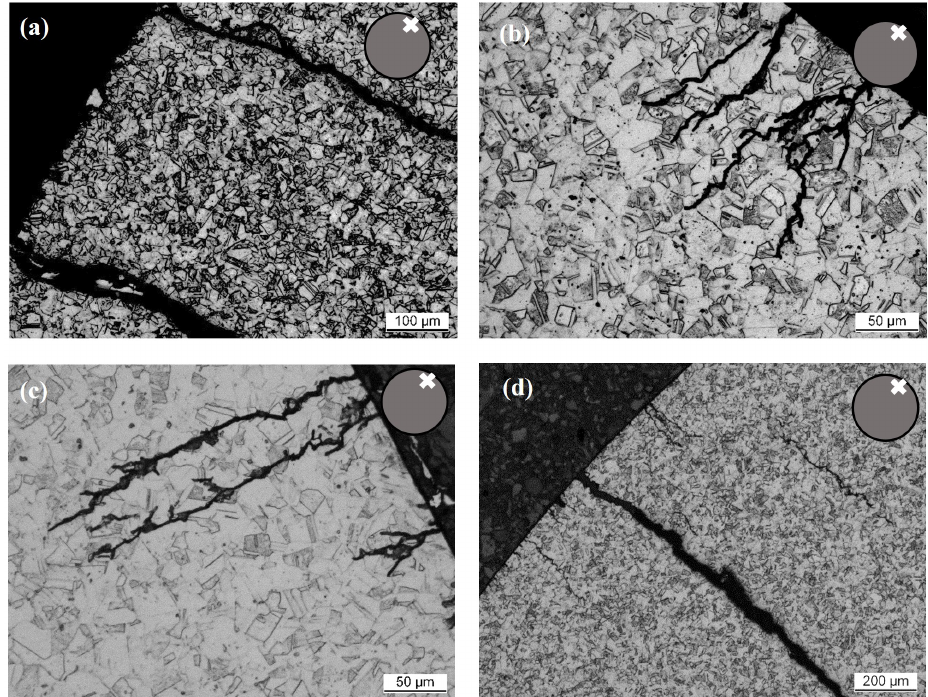
Figure 9. Light microscopic images of cross sections perpendicular to longitudinal axis through spec- imen loaded at 250 MPa and torsional angles of ( a ) 15 ◦ , ( b ) 12.5 ◦ , ( c ) 10 ◦ and ( d ) 7.5 ◦ . Cracks in radial direction branching inside the specimen are visible in all samples. Note the different